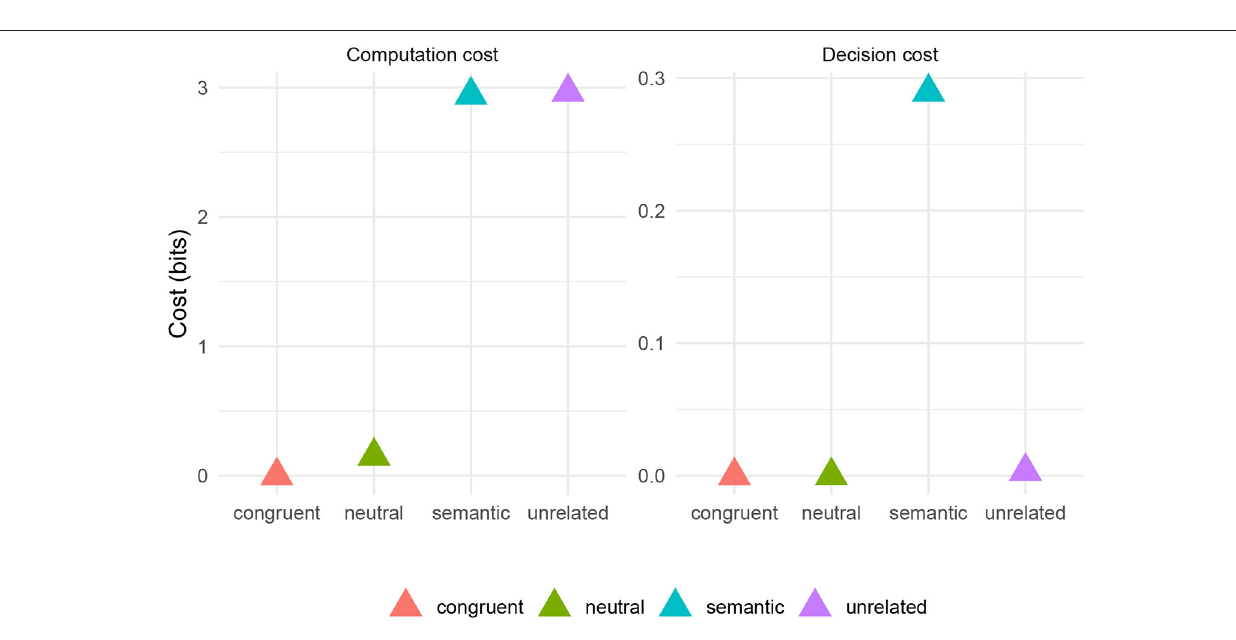
the time. Outside of a state with a neutral distractor s neutral , the probability of naming is still 1 10